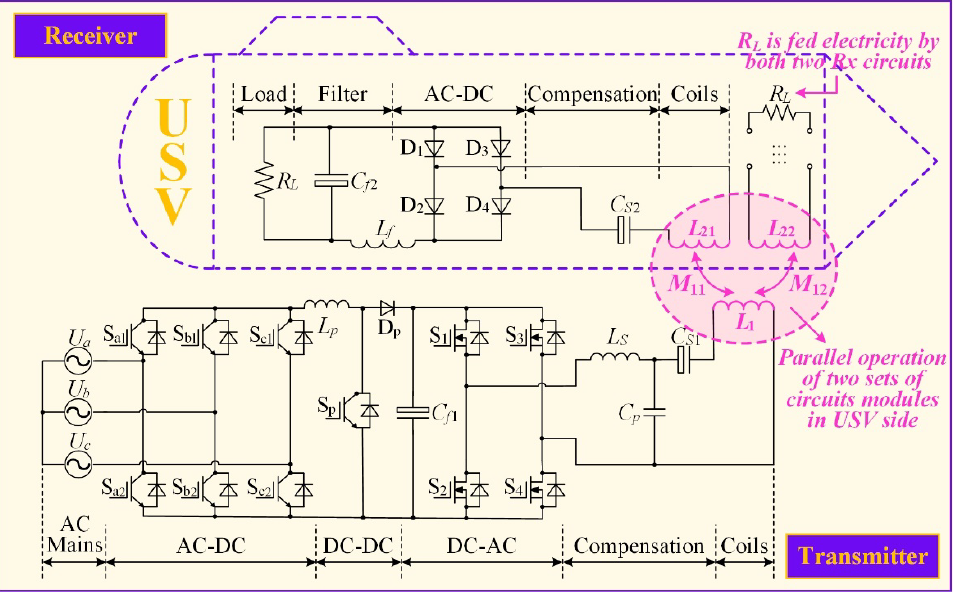
Figure 3. Circuit configuration of an LCC-S compensated UWCS by parallel operation on USV side .